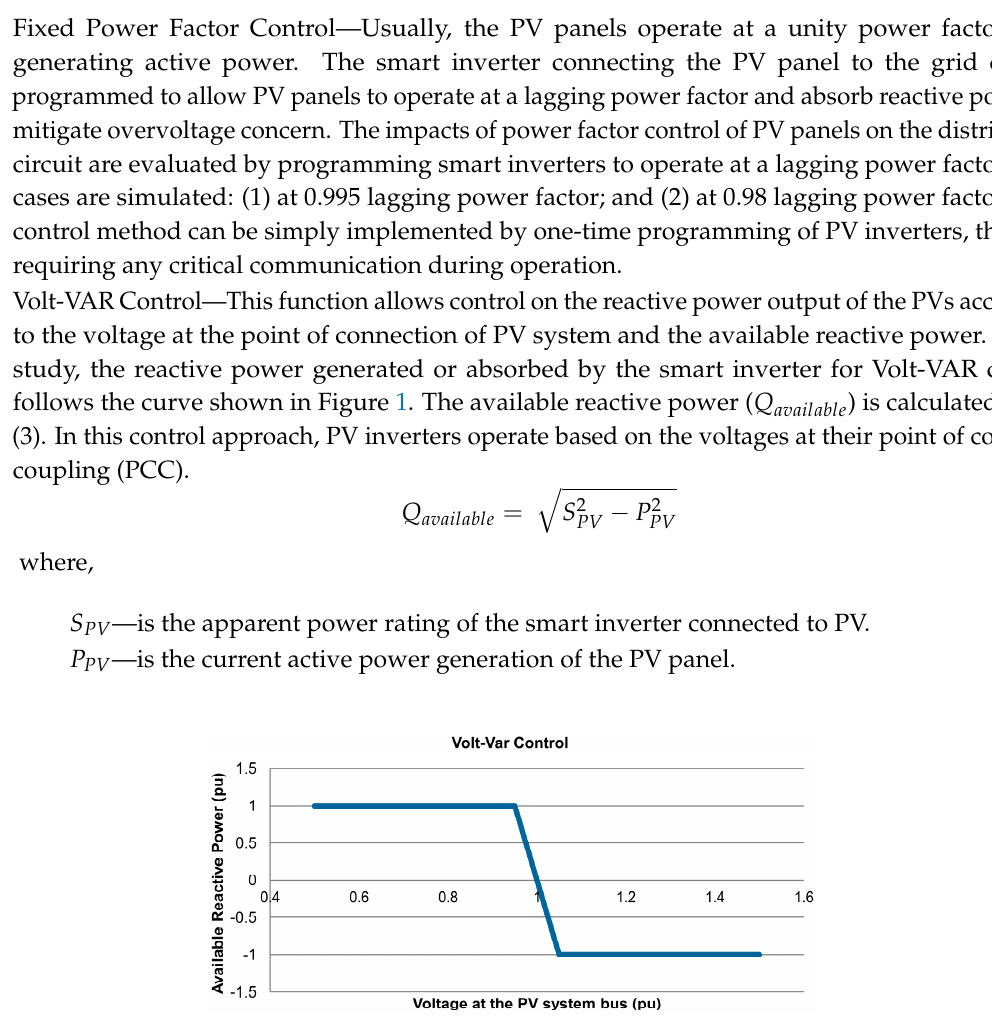
Figure 1. Volt-VAR Curve followed by smart inverters to control the VAR output of the PVs.